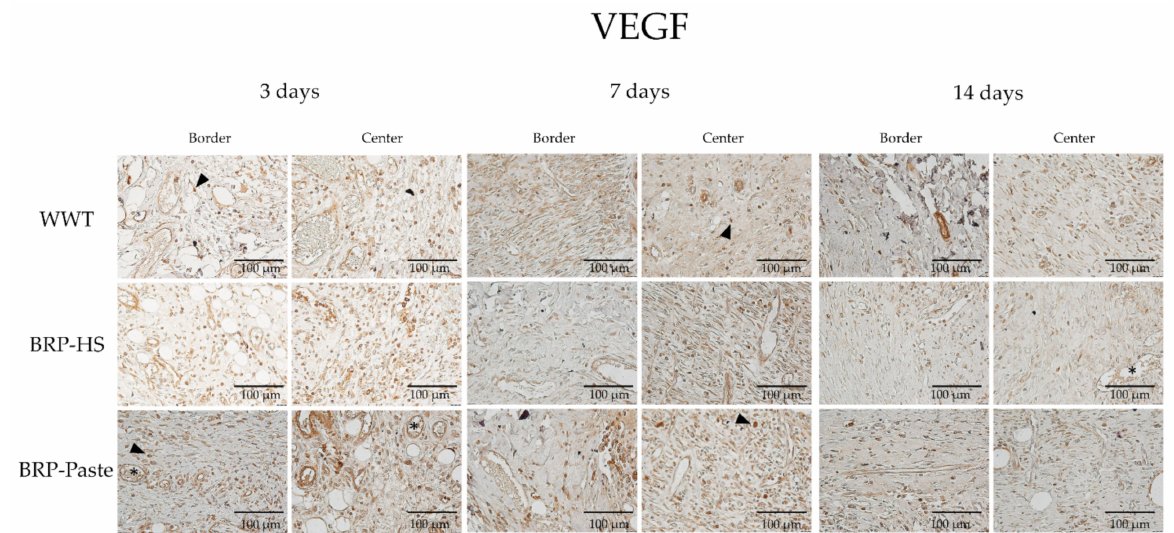
Figure 11. Photomicrographs of the dermis (40 × ), border and central regions of the wound from each experimental group in 3, 7 and 14 days of treatment for VEGF immunolabeling. VEGF positive cells in brown are represented by arrowheads and blood vessels by asterisks.